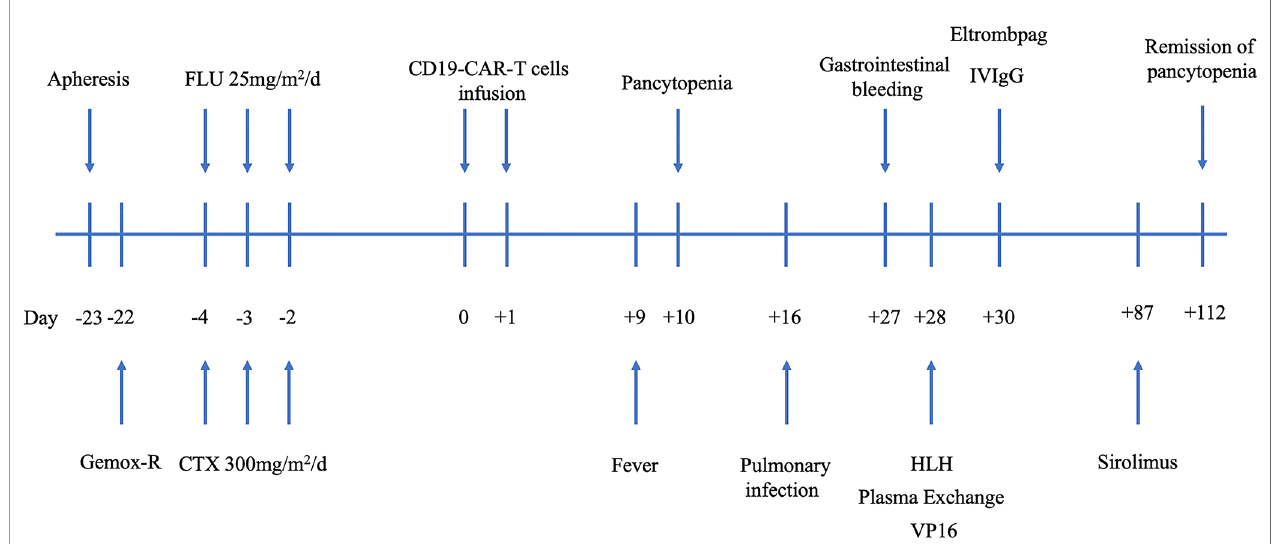
FIGURE 1 | Procedure of CD19 CAR-T cell manufacture and the clinical application scheme. CAR-T, chimeric antigen receptor T cell; CTX, cyclophosphamide; Gemox-R, Gemcitabine, Oxaliplatin, and Rituximab; HLH, hemophagocytic lymphohistiocytosis; VP16,